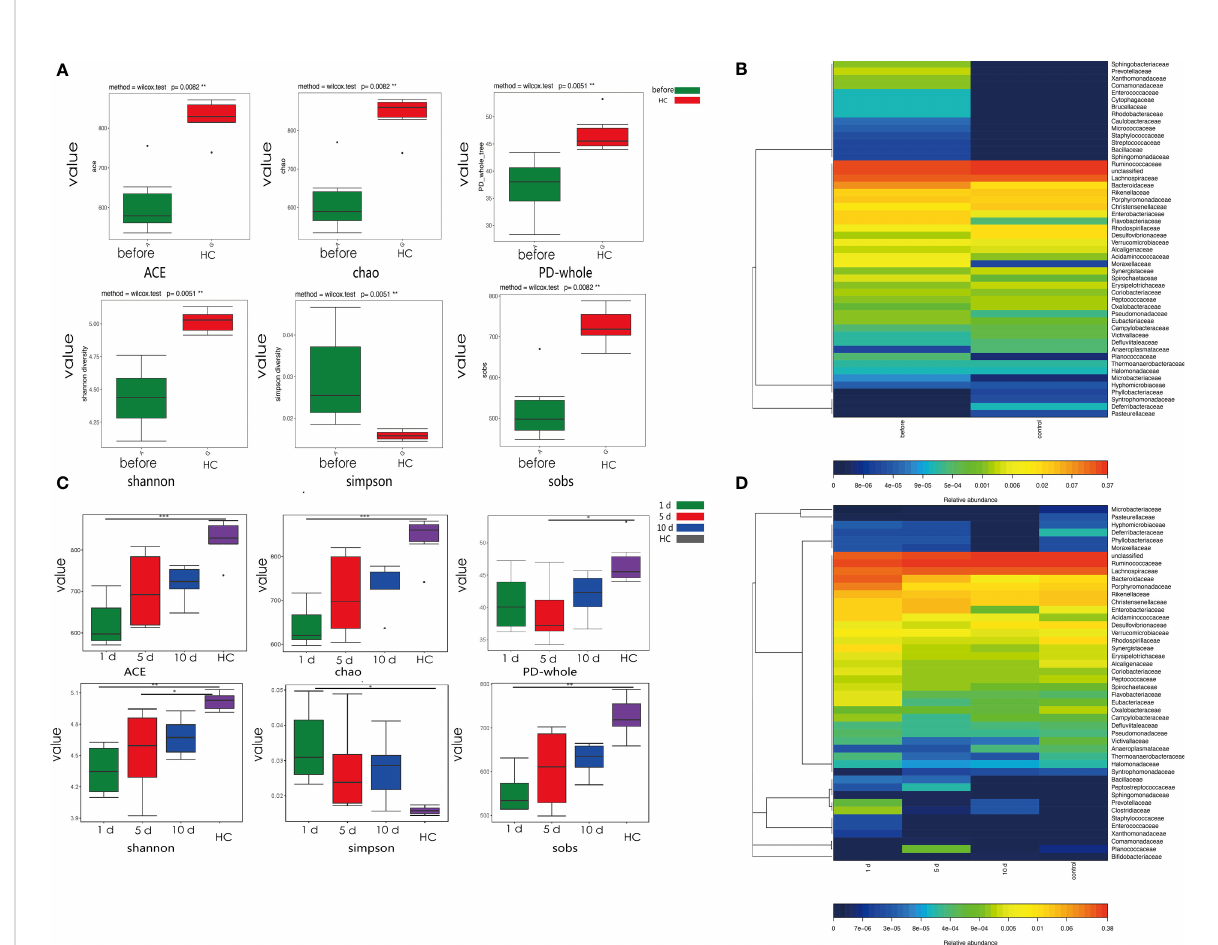
FIGURE 2 Phylogenetic diversity of gut microbiota in tumor models compared with HCs at different time points. (A) Alpha diversity in tumor models and HCs. Box plots depict greater diversity in HCs compared with tumor models, according to ACE, Chao, and Shannon indices. Horizontal lines in box plots show median values; upper and lower ranges in boxes show 75% and 25% quartiles. (B) Heat map comparisons in tumor models and HCs. (C) One, 5, and 10 days post-surgery, a -diversity in tumor models and HCs. Box plots depict greater diversity in HCs when compared with tumor models, according to ACE, Chao, and Shannon indices. Horizontal lines show median values; upper and lower ranges in boxes represent 75% and 25% quartiles. (D) Heat map comparisons at different time points in models and HCs. ***p < 0.001; **p <0.01; *p <